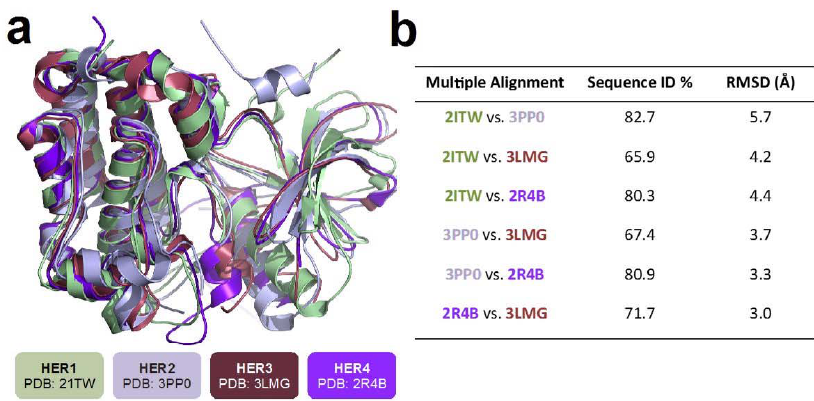
Figure 1. Superimposing of four human HER family structures (HER1-4) ( a ); Sequence identity and RMSD in angstrom (Å) for each HER Receptor ( b ).